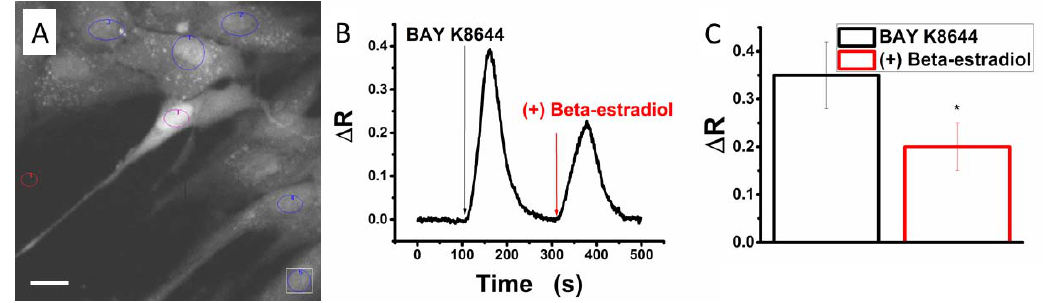
Figure 5. Beta ‐ estradiol effect on voltage ‐ gated calcium channels in TCs from pregnant uterine myometrium by Fura ‐ 2 ‐ based calcium imaging. ( A ) Cells in primary culture of human uterine myometrium loaded with Fura ‐ 2AM. The regions of interest (ROIs) are marked with circles corresponding to: red (reference field without cells), violet (TC), blue (other cells); Scale bar 20 μ m ( B ) representative traces of fluorescence ratio ( Δ R) changes induced by Bay K8644 (10 μ M) in the absence and presence of beta ‐ estradiol (1000 nM) in human myometrial TCs during calcium imaging recordings; ( C ) mean fluorescence ratio ( Δ R) ± SD, N = 5, in the same conditions as ( B ). The statistical analysis was done by the paired Student’s t test, and the level of significance is indicated with asterisks (* p < 0.05).